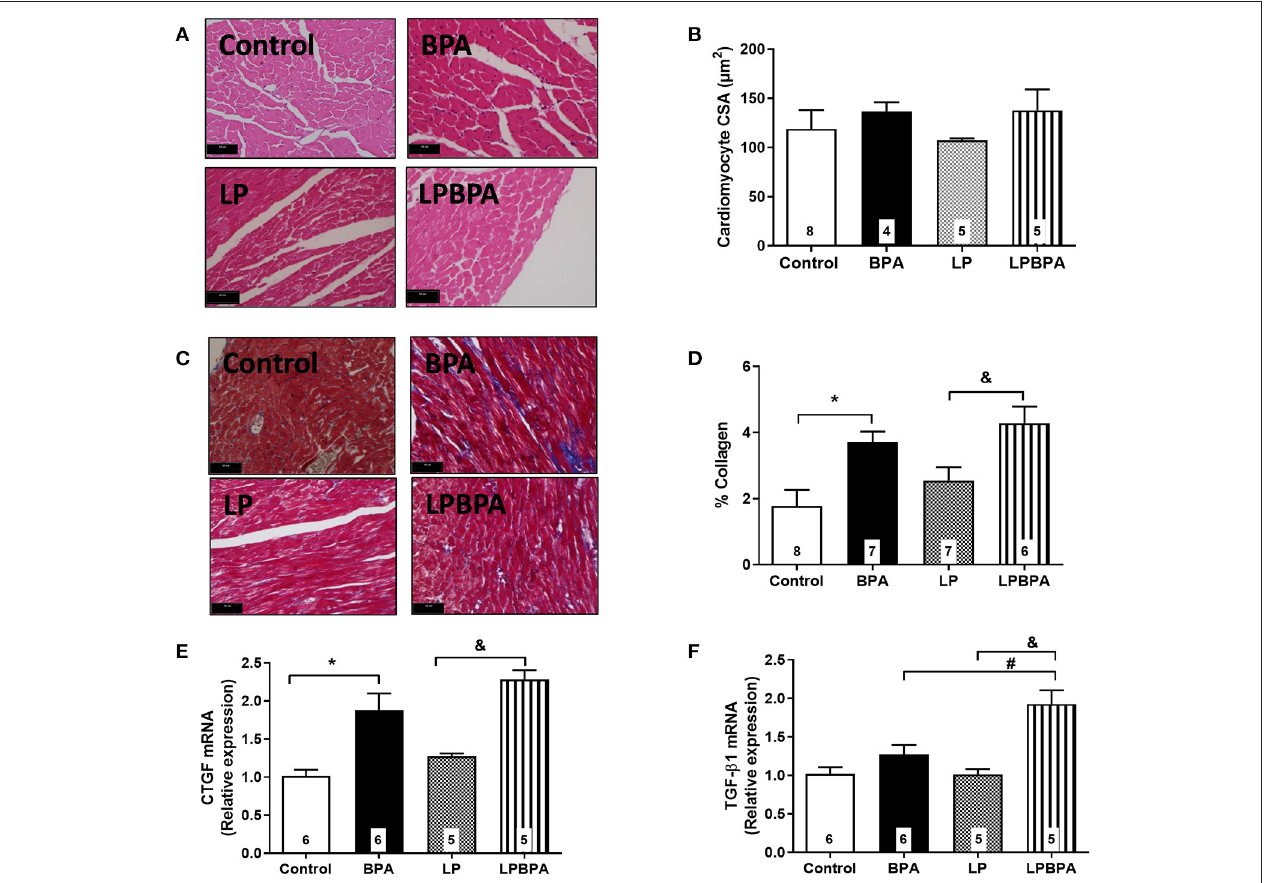
FIGURE 2 | Cardiomyocyte area, collagen deposition, and profibrotic gene expression in control and malnourished mice exposed to BPA. Representative images (bar = 50 µ m; × 40 magnification) for H.E. (A) and Masson staining (C) , cardiomyocyte cross-sectional area (CSA, B ), and % collagen deposition (D) in the myocardial left ventricle of mice fed normoprotein (control) or low-protein (LP) diet during 8 weeks and exposed to BPA for 9 days. CTGF (E) and TGF- β 1 (F) mRNA expression was quantified in LV samples. Data are expressed as the mean ± SEM (number of animals/group is indicated in the bars). One-way ANOVA followed by the Newman-Keuls test; * p < 0.05 vs. control; & p < 0.05 vs. LP; # p < 0.05 vs. BPA.